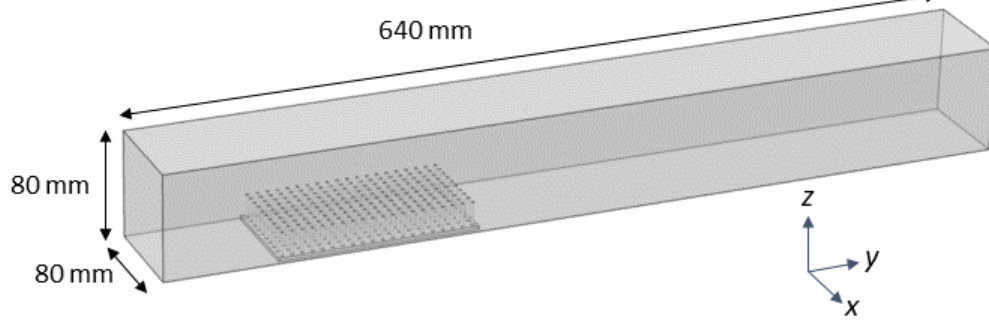
Figure 3. Computational domain for COMSOL fluid physics simulations. The domain represents the experimental setup in the flow tank and is an 80 mm × 640 mm × 80 mm box. Parabolic inflow conditions and zero pressure outflow conditions are used. No slip conditions were used